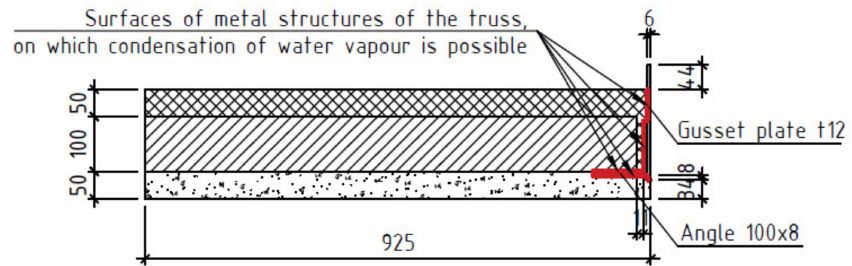
Figure 7. Surfaces of the metal elements of the truss’s bottom chord, where condensation of water vapor is possible (units: